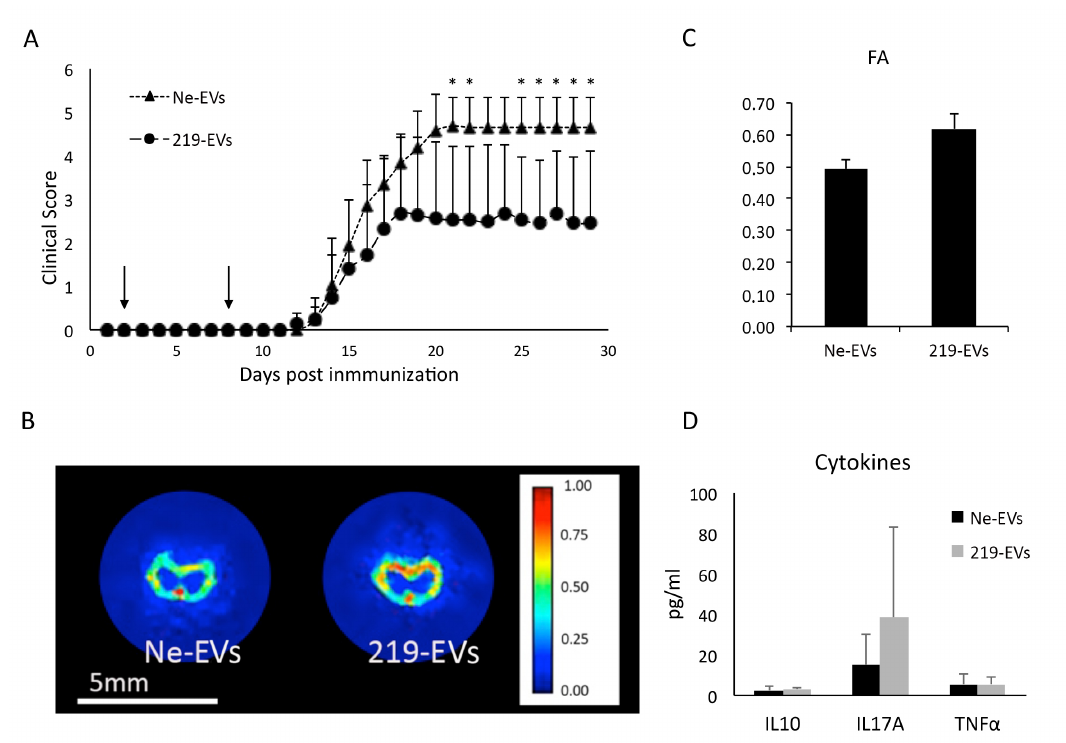
Figure 5. Intranasal administration of miR-219a-5p enriched exosomes promotes myelin regeneration. ( A ) Clinical evaluation of animals treated with non-enriched extracellular vesicles (Ne-EVs) and with miR-219a-5p enriched extracellular vesicles (219-EVs) (100 µ g of EVs per dose; animals received two doses at days 2 and 8 after disease induction). 219-EVs treated animals showed a significant decrease in the clinical evaluation after the disease peak ( n = 4). ( B ) MRI of spinal cord of a Ne-EVs treated animal and a 219-EVs treated mouse showing the fractional anisotropy (FA). ( C ) FA values of a section of the spinal cord of previous animals showing a decrease in FA values when treatment was Ne-EVs, indicating that remyelination is occurring. ( D ) No significant di ff erences between both groups in pro-inflammatory cytokines were found, indicating that the e ff ect induced by EVs was not related to an anti-inflammatory